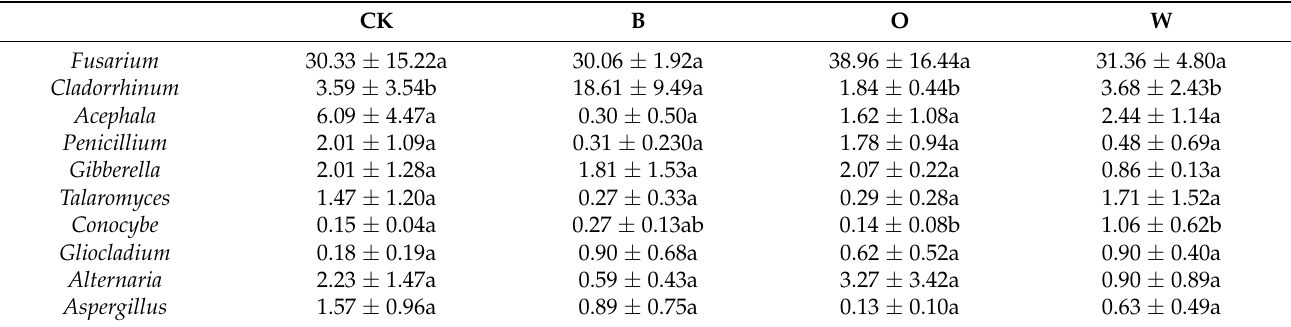
Table 3. Relative abundances of dominant fungal genus in